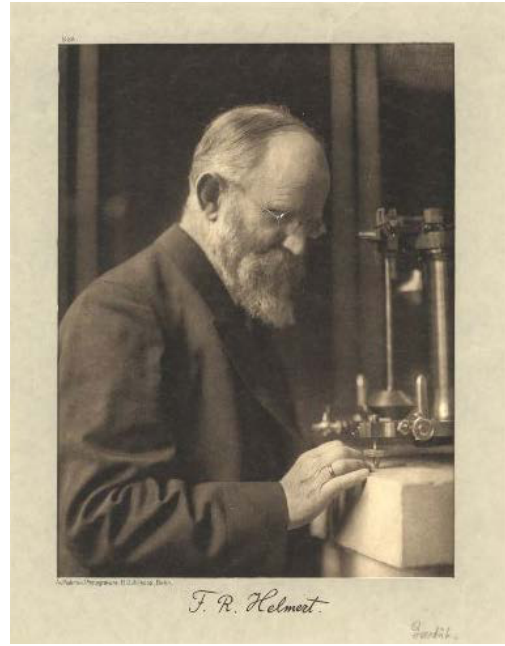
Figure 6. Friedrich Robert Helmert with a relative pendulum (Humboldt University Berlin, ©Humboldt-Universität zu Berlin,